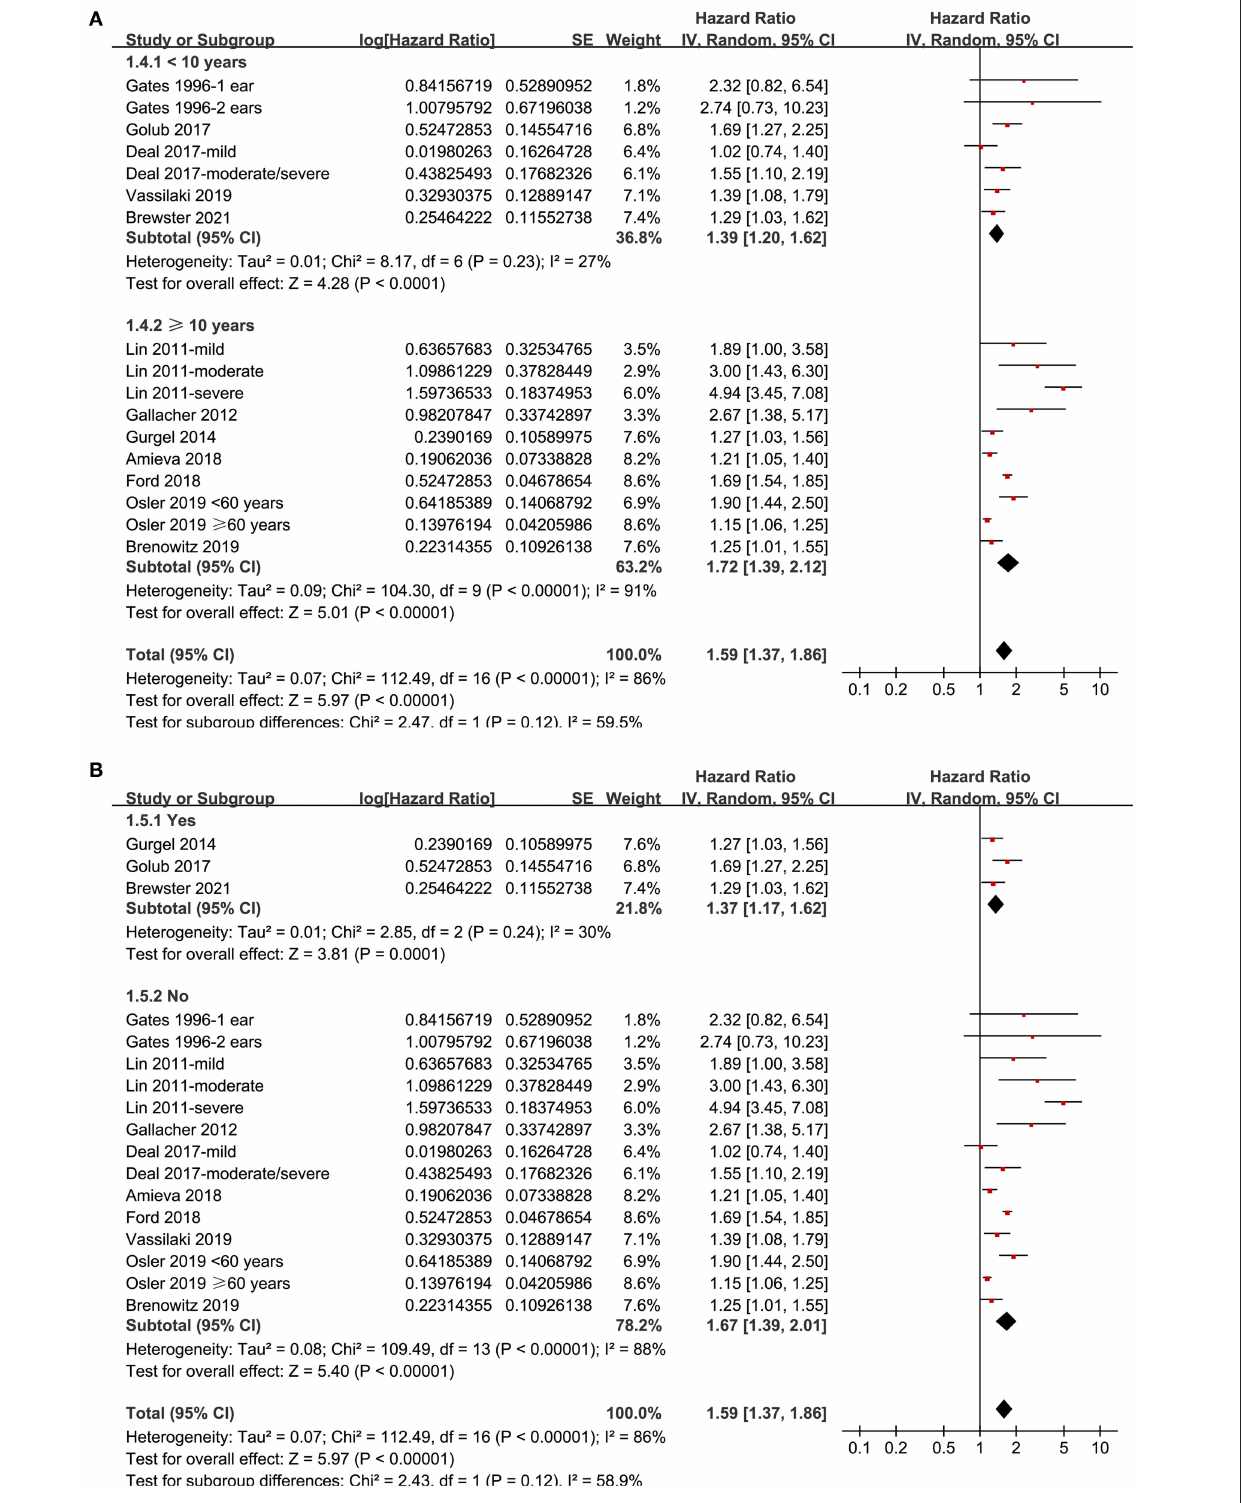
Frontiers in Aging Neuroscience |